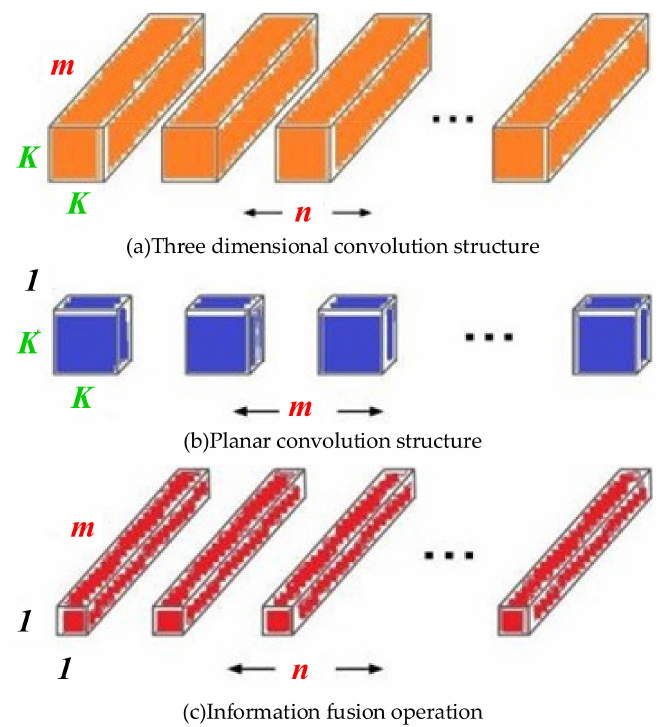
Figure 2. The depthwise separable convolutional